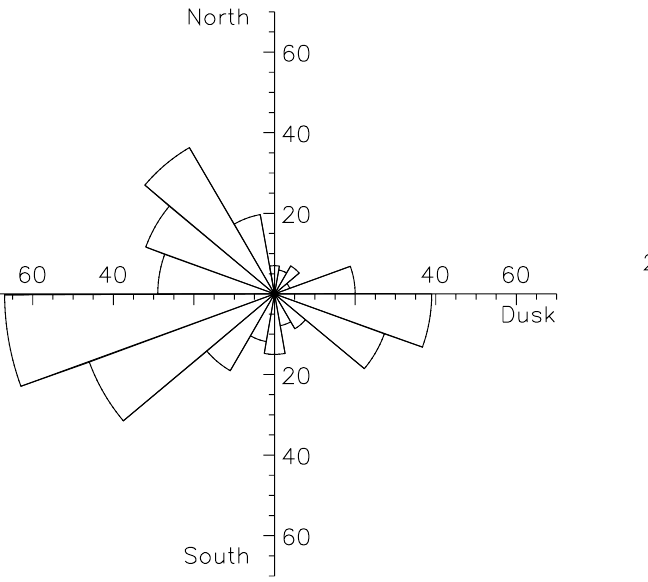
Fig. 2. A polar histogram of the IMF clock angle at the time of each magnetopause crossing. The figure takes the same format as Fig.